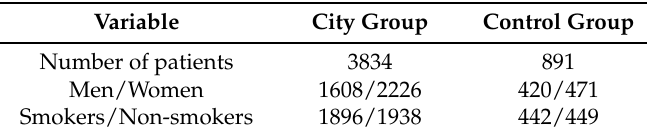
Table 5. Elementary information on city and control